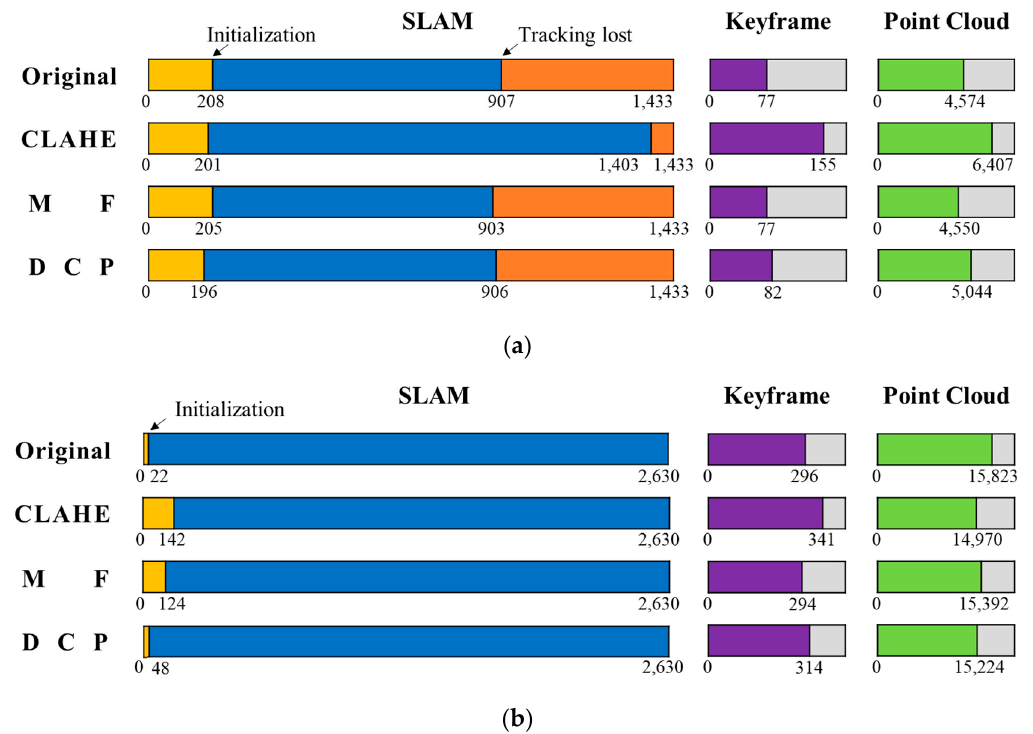
Figure 12. SLAM running result data. ( a ) Test 1 dataset; ( b ) Test 2 dataset. Initialization is the beginning of SLAM, and faster initialization means more image feature points are matched and the image quality is better. In both datasets, DCP has the shortest initialization time among the three image enhancement methods. The tracking loss is due to the fact that not enough feature points were extracted, and the system started to wait to enter relocation. In the Test 1 dataset, where tracking loss occurs, the CLAHE method performs best. In ORB-SLAM2, the keyframe selection rules are to determine whether the distance from the previous keyframe is more than 20 images, whether the current frame tracking is less than 50 point clouds, and whether the current frame tracking is less than 90% of the reference keyframe point cloud. CLAHE has the most keyframes, especially in Test 1, which is almost twice as many as the other results. The point clouds are determined by the number of feature points of keyframes, and the number of point clouds varies due to different keyframe selection and keyframe feature points, but the overall quantitative difference is not